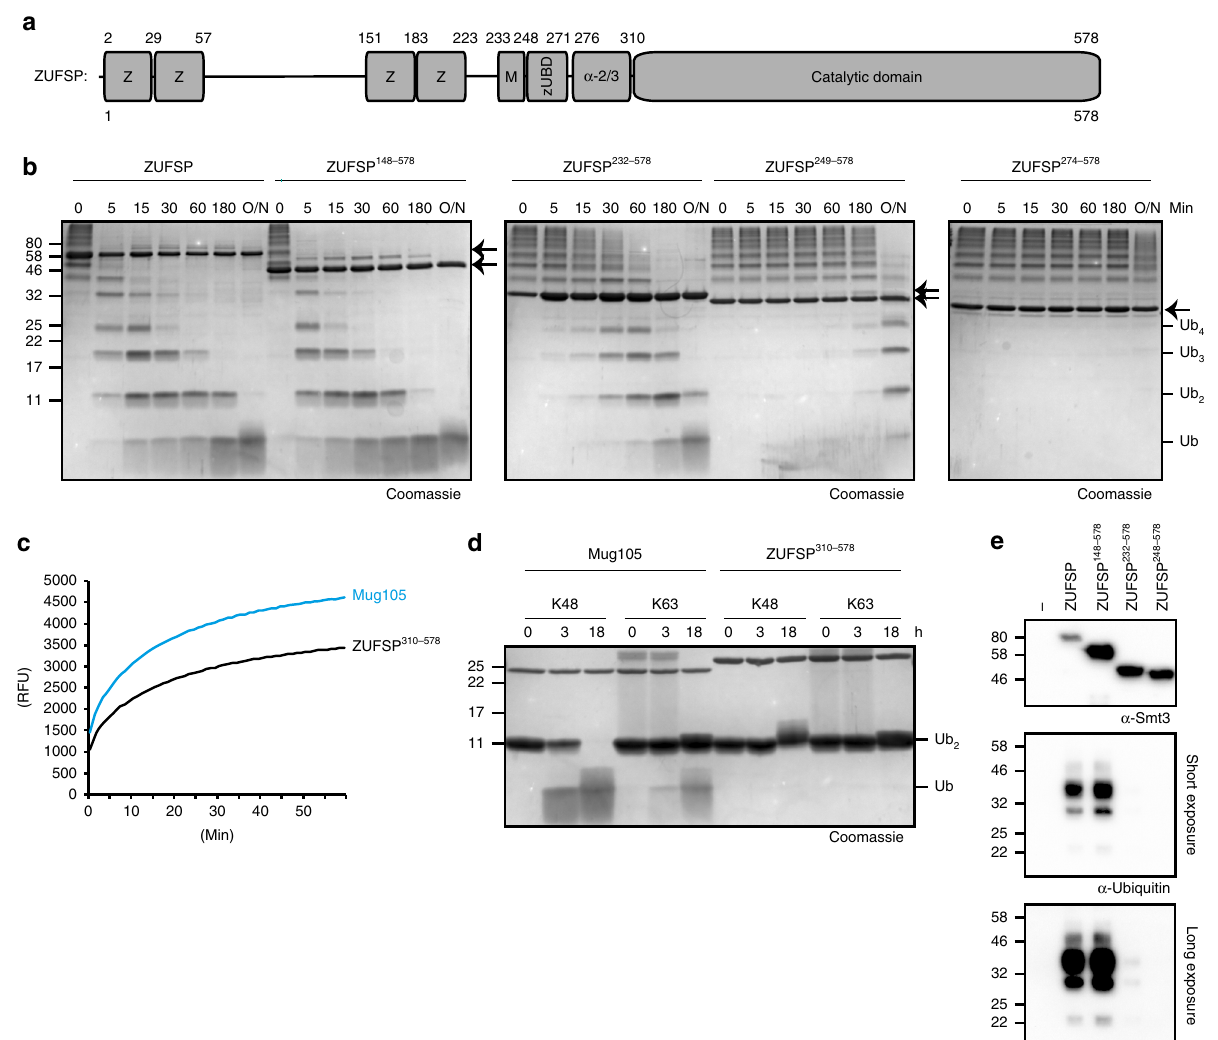
Fig. 4 ZUFSP UBDs contribute to chain cleavage and speci fi city. a Schematic representation of ZUFSP domain architecture. UBZ-like zinc fi ngers (Z), MIU domain (M), novel ZUFSP ubiquitin-binding domain (zUBD) and α 2/ α 3 region are shown as boxes. b Activity of ZUFSP FL and truncations lacking the UBDs against K63-linked Ub 6 + chains. Positions of the truncated ZUFSP proteins are indicated by arrows. c Comparison of Mug105 and ZUFSP 310-578 activity against ubiquitin-AMC. The shown RFU values are the mean of triplicates. d Chain speci fi city of ZUFSP catalytic core (ZUFSP 310-578 ) compared to full-length Mug105. Both DUBs were tested against K48- and K63-linked Ub 2 for the indicated time points. e Pull-down analysis of ZUFSP (full-length and two N-terminal truncations) against a mixture of K63-linked Ub 4 and Ub 5